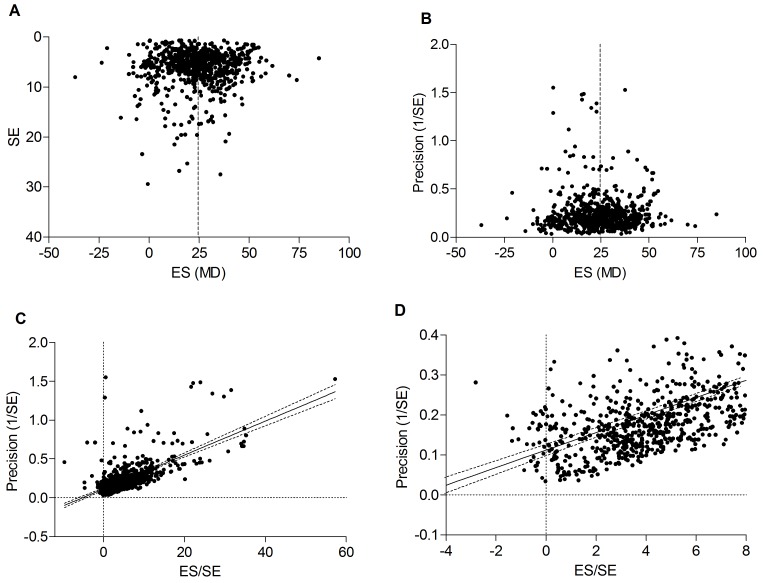
Assessment of publication bias.Visual inspection of funnel (A) and precision (B) plots suggested an underrepresentation of studies with moderate precision and small effect sizes, but this was not confirmed by trim and fill analysis. Dotted line represents the overall effect size of 24.6. C-D: Egger's regression test revealed that small study effects are likely present, since the regression line does not intercept at the origin. ES = effect size; SE = standard error; MD = raw difference in means.